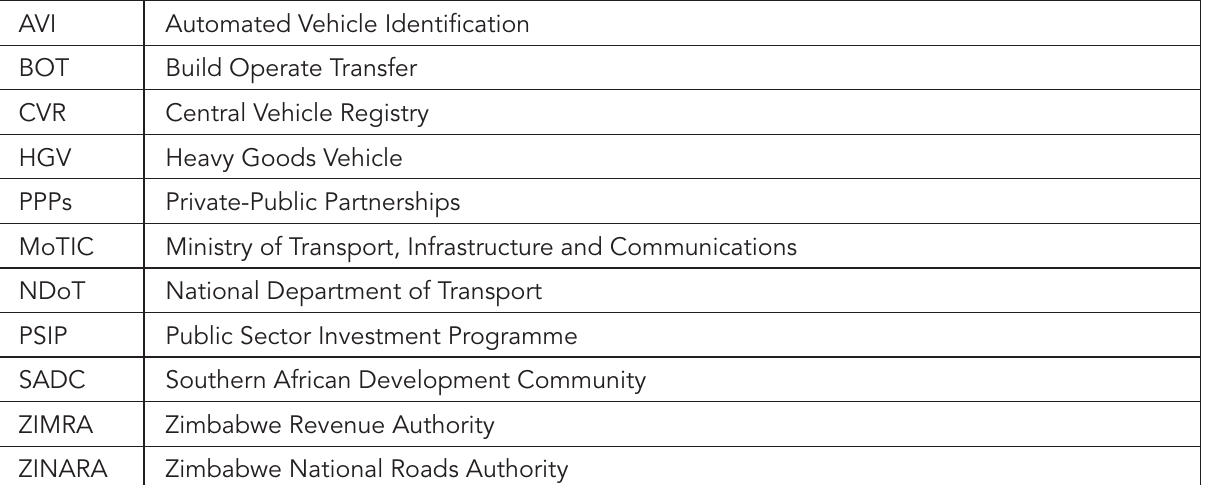
AVI Automated Vehicle